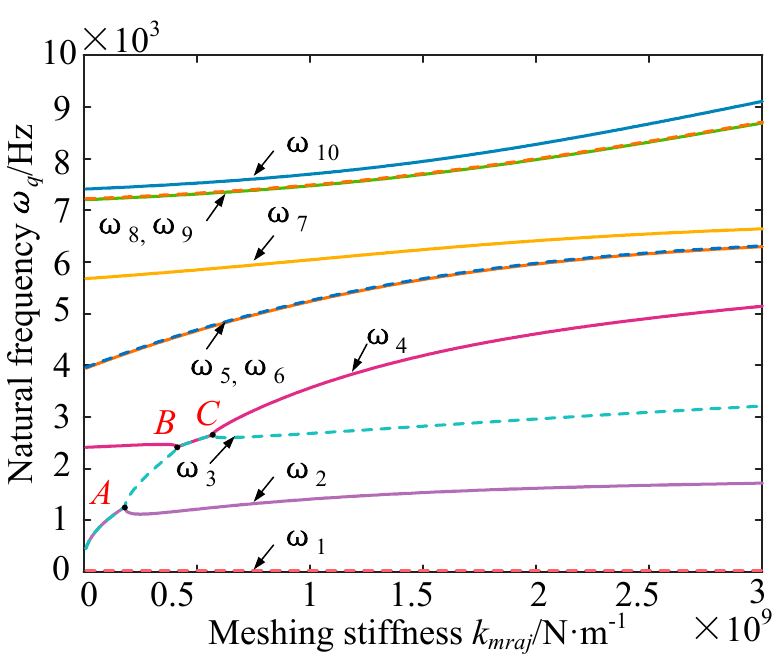
. (cid:3040)(cid:3045)(cid:3028)(cid:3037)